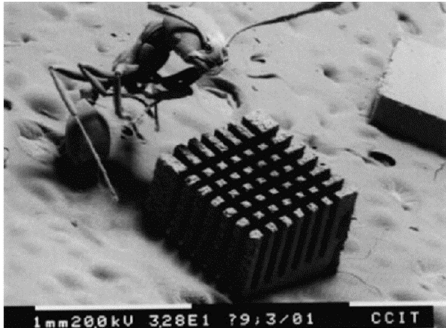
Figure 8. SEM view of micro-slits fabricated on the surface of Ti-alloy using SiC-mixed EDM process